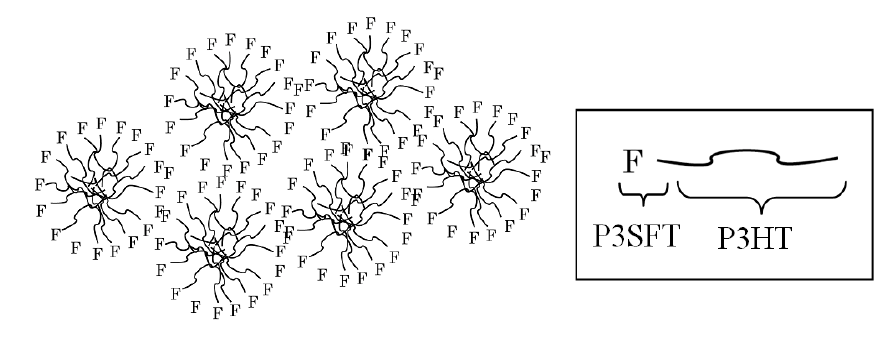
Figure 5. The model image of phase separation of P(3HT- b -3SFT).